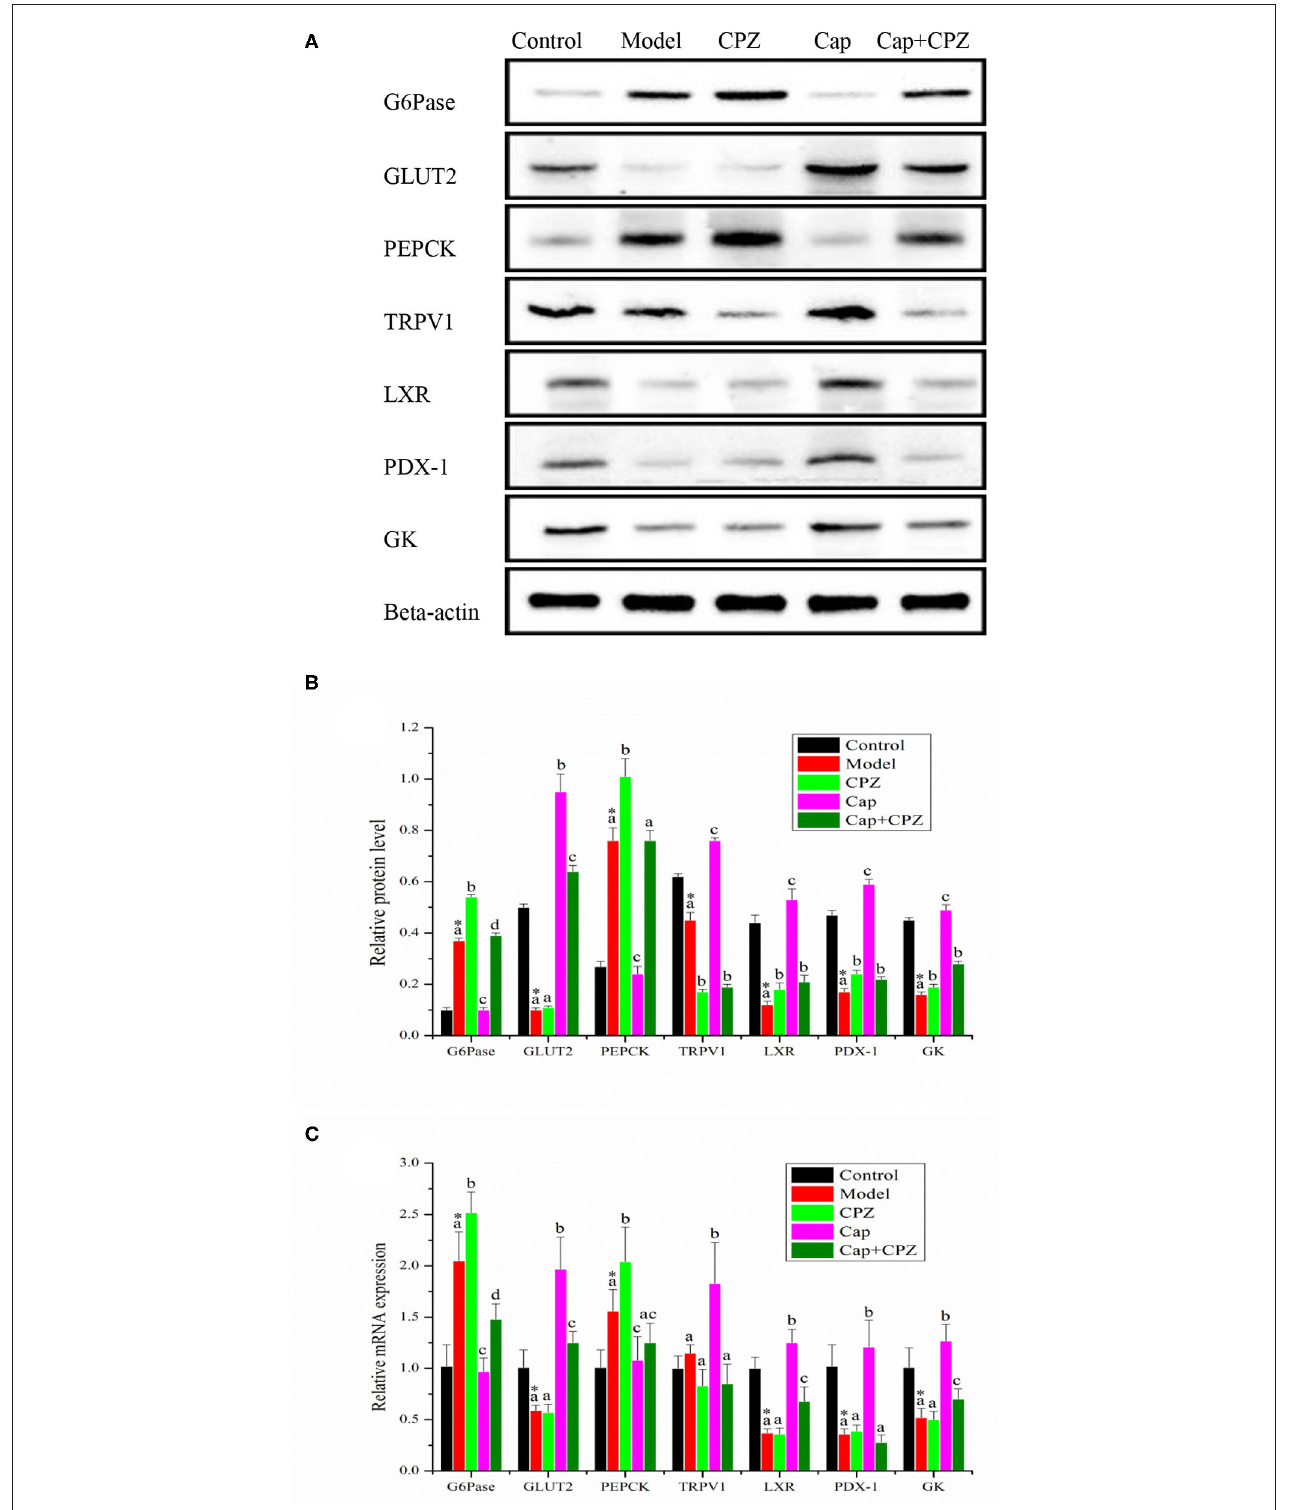
FIGURE 4 | Effects of TRPV1 receptor antagonist and capsaicin on protein (A,B) and mRNA (C) expression levels of key genes for glycometabolism in liver of STZ-induced diabetic rats. All data are expressed as means ± SD, n = 8. *Means are significant difference compared with the control group ( P < 0.05). Means with different superscript letters are significantly different among the diabetes groups ( P < 0.05). G6pase, glucose 6 phosphatase; GLUT2, glucose transporter 2; PEPCK, phosphoenolpyruvate carboxykinase; TRPV1, transient receptor potential cation channel subfamily V member 1; LXR, liver X receptor; PDX-1, pancreatic duodenal homeobox 1; GK, glucokinase. Effective concentrations of capsaicin and capsazepine are 6 and 10 mg/kg · BW, respectively.